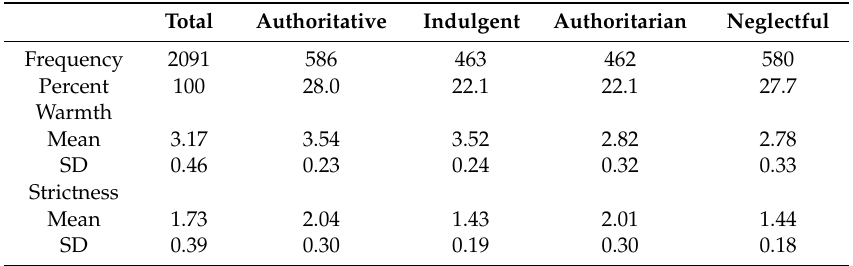
Table 2. Distribution of parenting style groups, mean scores, and standard deviations on main measures of parental